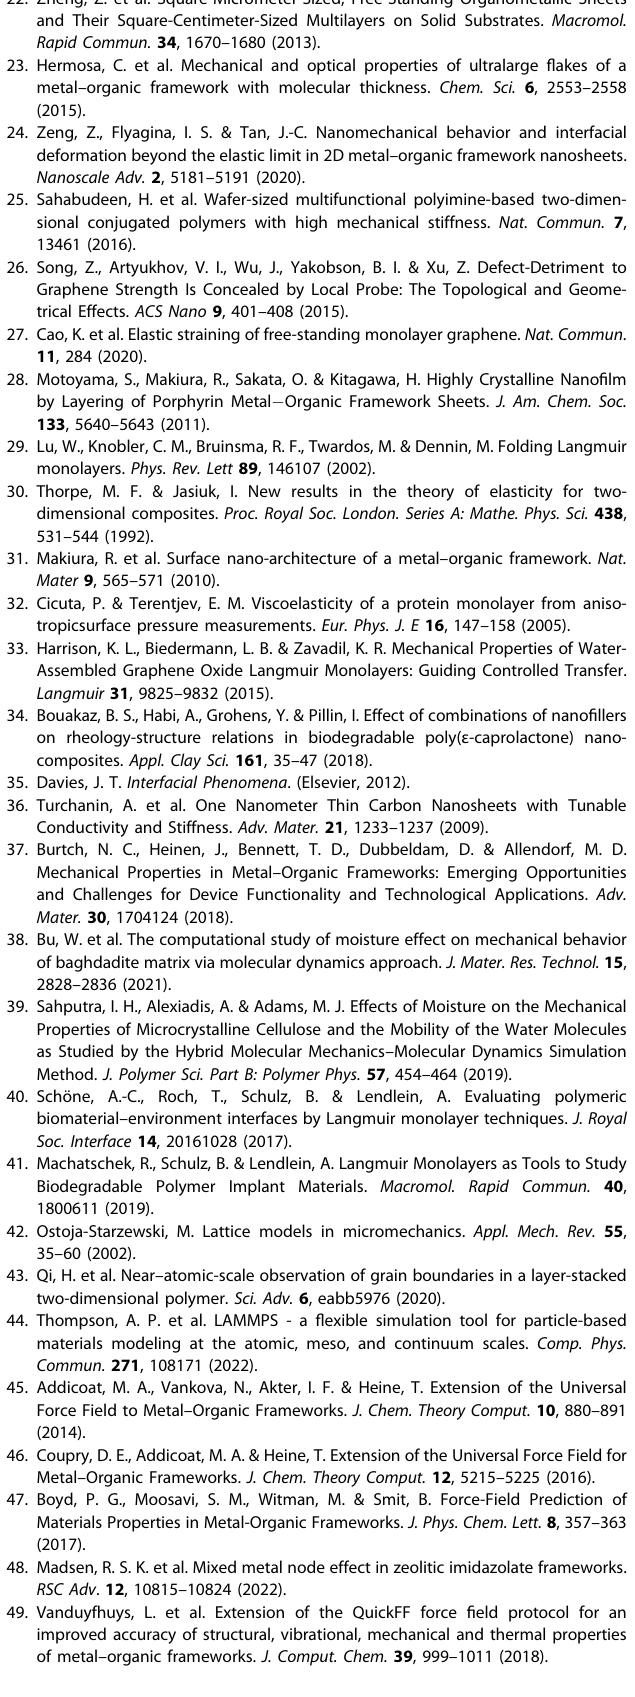
Supplementary Fig. 8, and the stepwise tensile scheme and the stress-strain curve along deformation are summarized in Supple- mentary Fig. 9 and Fig. 5b. Unlike the pure 2D MOF without water, the potential fl uctuation of the MOF on the water layer is too large to extract information from it. The Young ’ s modulus of the 2D MOF on the water layer is calculated from the slope of the stress- strain